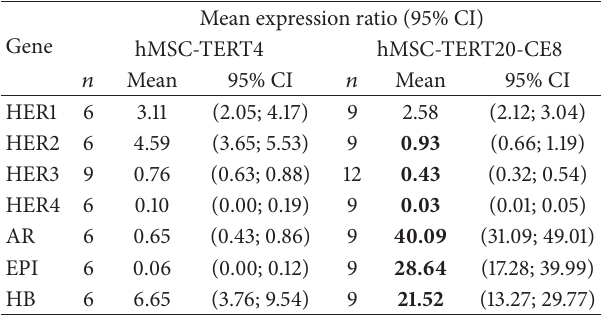
Table 1: The mean mRNA expression ratio of HER1, HER2, HER3, and HER4 receptors for the EGF system and the ligands AR, EPI, and HB for the parental cell line hMSC-TERT4 and the derived clonal cell line hMSC-TERT20-CE8 with the ability to form sarcoma-like tumours in mice. All expressions levels are normalized to reference gene B2M. The numbers in bold represent the gene that exhibits significant changes when comparing hMSC-TERT20-CE8 with the parental cell line